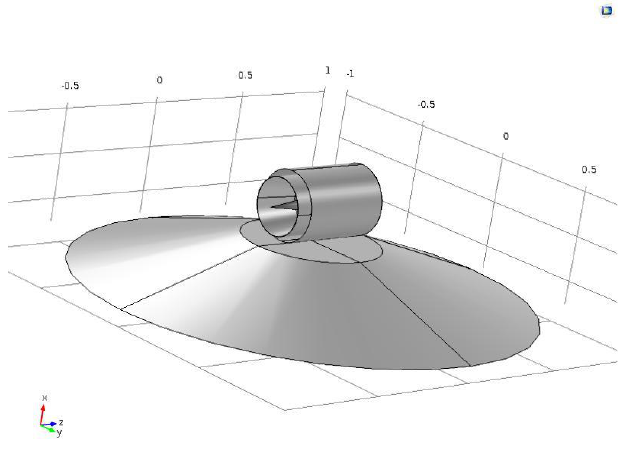
Figure 3. One of the options of the closed-type wind turbine housing computational